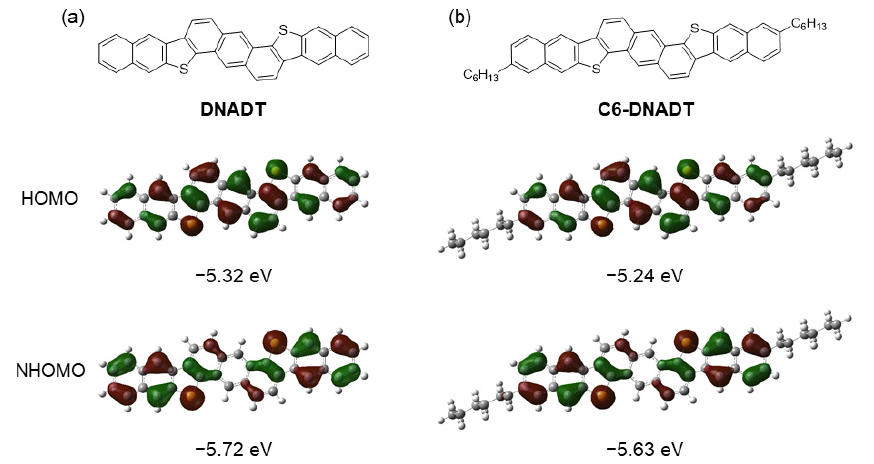
Figure 1. Molecular structures and highest occupied molecular orbital (HOMO) and next highest occupied molecular orbital (NHOMO) (B3LYP/6-311G(d)) of ( a ) dinaphtho[2,3- d :2’,3’- d’ ]anthra[1,2- b :5,6- b’ ]dithiophene (DNADT) ( 1 ) and ( b ) 4,14-dihexyldinaphtho[2,3- d :2’,3’- d’ ]anthra[1,2- b :5,6- b’ ]dithiophene (C6-DNADT) ( 2 ).